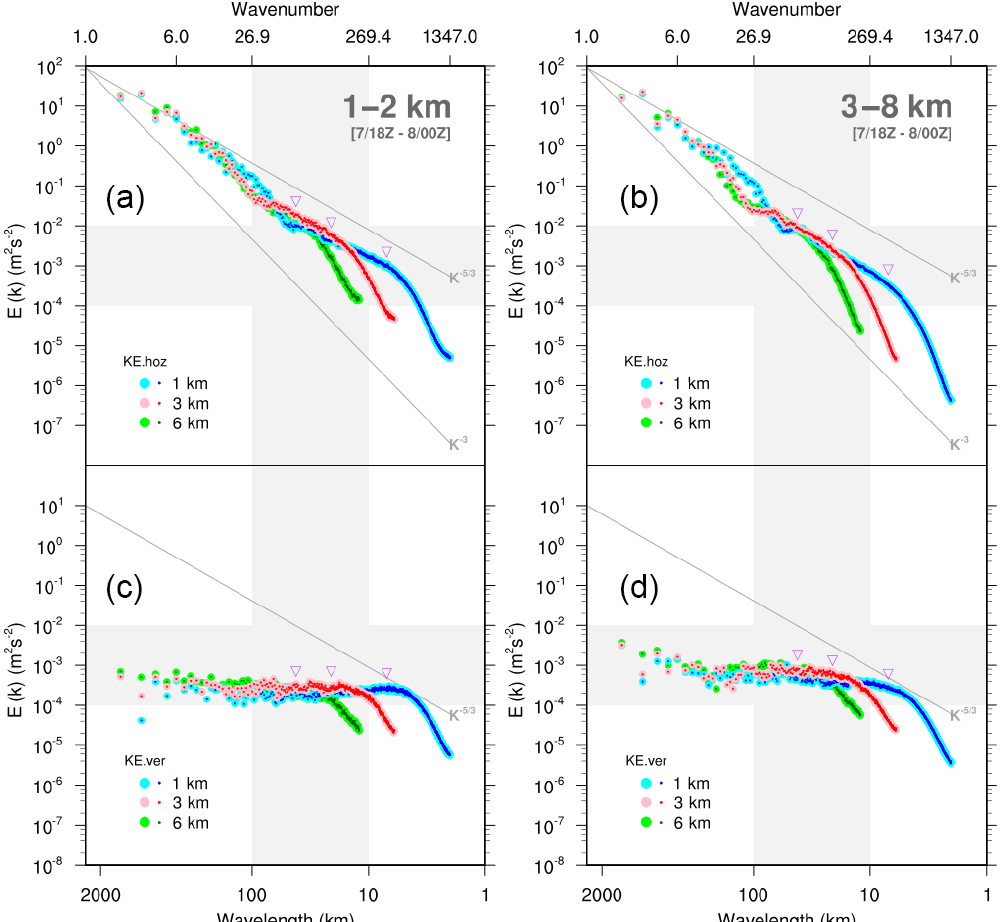
Figure 16. Mean KE spectra for horizontal wind (a, b) and vertical velocity (c, d) for all simulations as computed over the boundary layer ( a , c ; between 1 and 2km) and free troposphere ( b , d ; between about 3 and 8km) for the mature stage. The mature stage is indicated by the average between 18:00UTC on 7 November 2013 and 00:00UTC on 8 November 2013. The gray lines correspond to the expected slopes for the large scale ( − 3 slope) and mesoscale to smaller scales ( − 5 / 3 slope) of the atmospheric kinetic energy spectrum. The wavelength and wavenumber are given on the lower and upper x axes, respectively. The purple triangles in each panel, from left to right, denote the locations of 7DX for the simulations of resolutions 6, 3, and 1km, respectively. The domain of the spectral decomposition is shown in Fig.